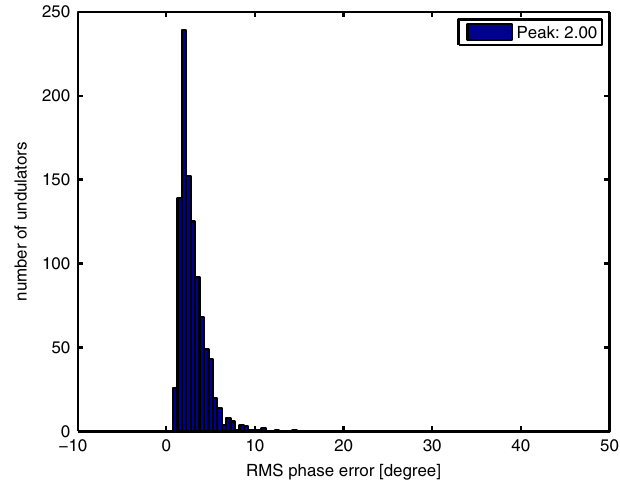
FIG. 9. (Color) Phase-error distribution for 1000 50-period un- dulators with induction shimming; (cid:7) (cid:2) B=B; coil ¼ (cid:7) (cid:2) B=B; pole ¼ 3 (cid:6) 10 (cid:3) 3 .